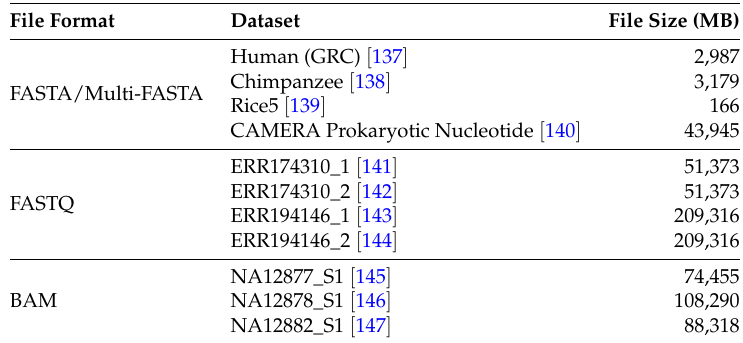
Table 1. Genomic sequence datasets used by reference-free compression methods.